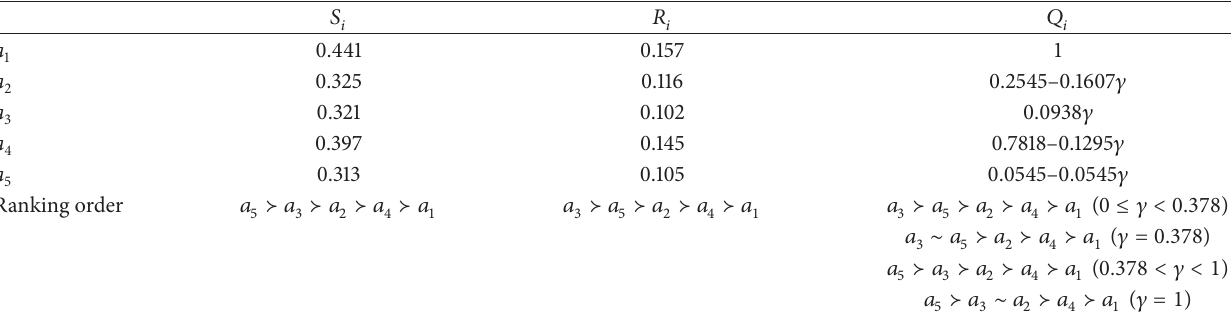
Table 1: Decision result obtained from the extended VIKOR